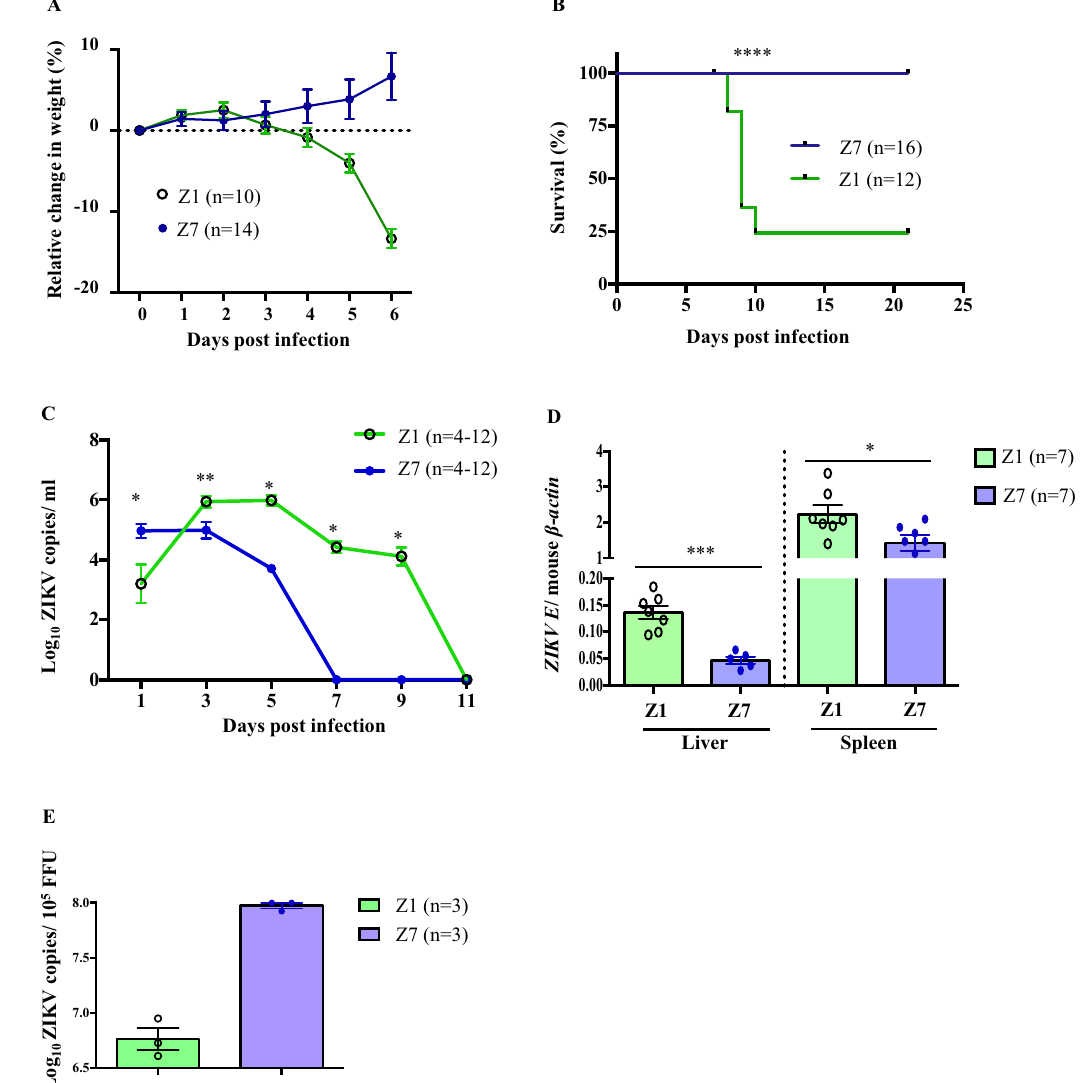
Fig. 4 Z7 exhibits attenuated infectivity in Ifnar1 − / − mice. Four-week-old Ifnar1 − / − mice were inoculated with 1 × 10 5 FFU of Z1, or Z7 (G10) through footpad. A Relative changes in body weight. B Survival curves. Mice were monitored daily for 21 days to determine survival. C Viremia of Z1 and Z7 infected mice. Mice were bled every-alternate day from D1 to D11 p.i., and the viremia was determinized by measuring the ZIKV genome copies ( ZIKV E ) by qRT-PCR. D Viral load in the liver and spleen tissues. Z1 or Z7 (G10)-infected mice were sacri fi ced on D3 p.i. to harvest the livers and spleens. The viral burden was measured by qRT-PCR and expressed as the ratio of the copy numbers of ZIKV E to mouse β -actin . E Viral RNA was extracted from the viral stocks containing 1 × 10 5 FFU of Z1 or Z7 (G10). The ZIKV E genome copies were quali fi ed by qRT-PCR. Data were compared with a log-rank test ( B ), Mann – Whitney U tests ( C , E ), a two-tailed Student ’ s t -test ( D ) and presented as mean ± s.e.m. with * p < 0.05, ** p < 0.01, *** p < 0.001, and **** p <